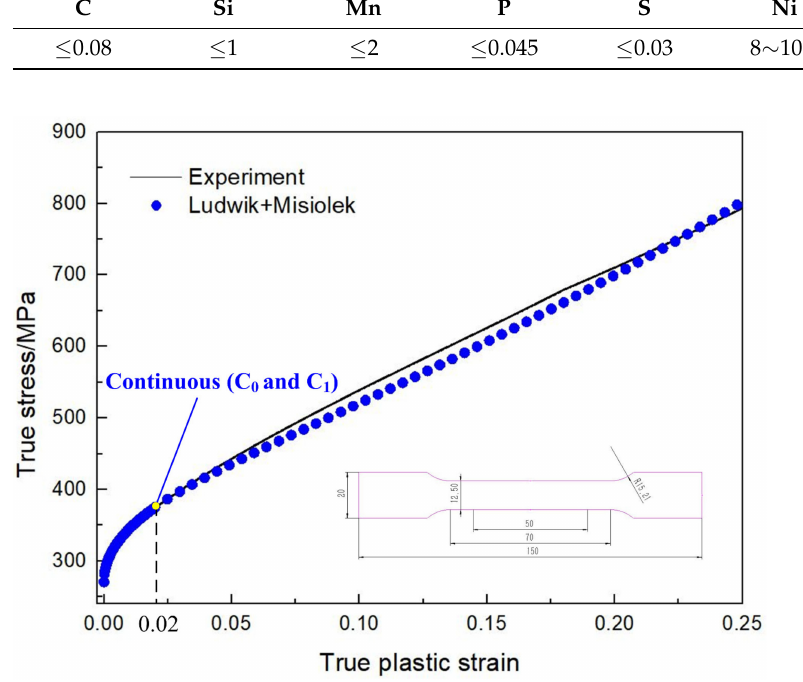
Figure 4. Fitting result of the flow stress model. Table 2. SUS304 stainless steel material